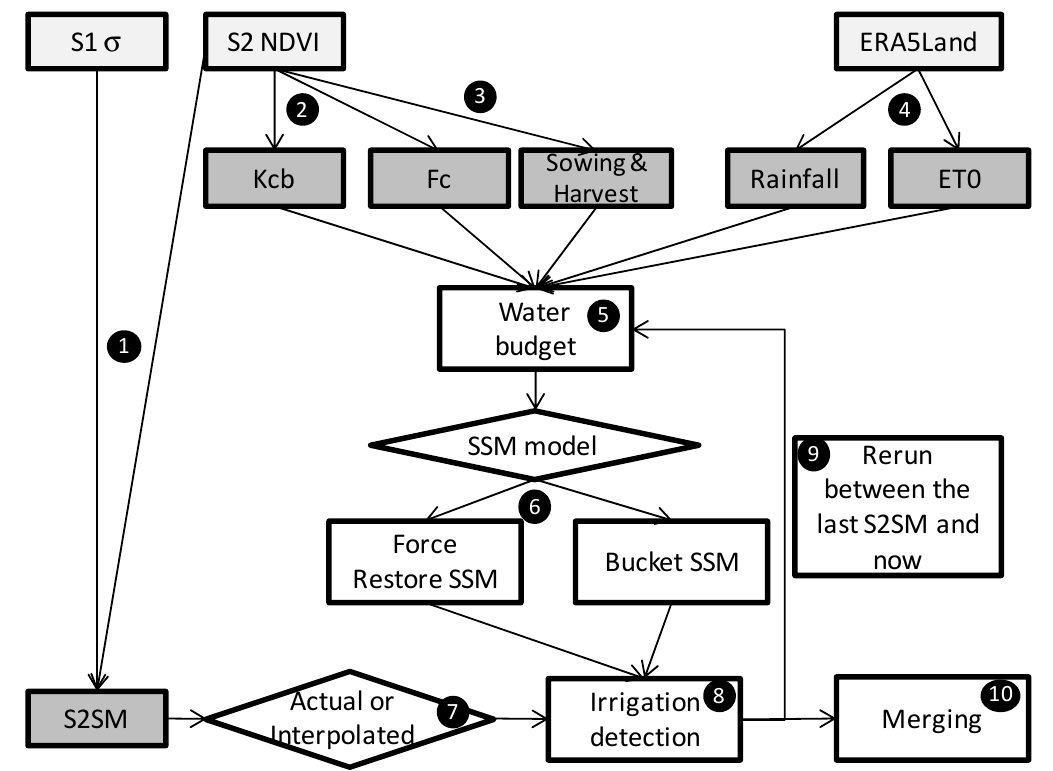
Figure 8. The workflow of this article is based on three datasets (in light gray boxes). The steps 1 to 4 allow to obtain intermediate variables, with, on one side, the Surface Soil Moisture product obtained from satellite observations (S2SM), and, on the other side, the variables that will allow the computing of a water budget for the estimation of the surface soil moisture (basal crop coefficient (Kcb), Fraction cover (Fc), sowing and harvest date, precipitation and reference evapotranspiration (ET0)). Steps 5 to 9 are the irrigation detection steps. The two diamonds (6 and 7) indicate sub-methods for dealing with soil moisture observation and soil moisture estimation, respectively. The final step (10) consists of merging